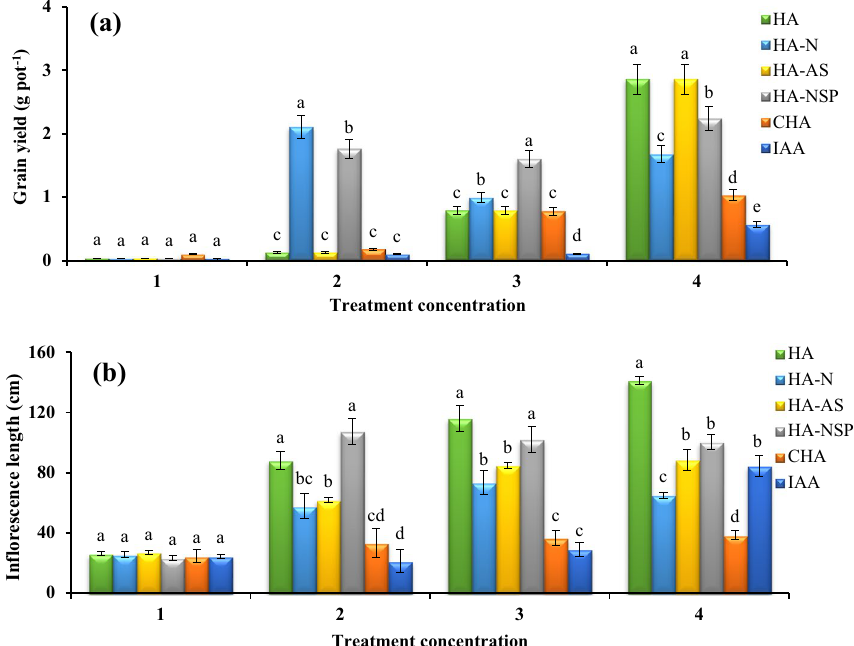
Figure 4. Comparison of average foliar application of experimental treatments on grain yield ( a ) and inflorescence length ( b ) at treatment concentrations (levels 1, 2, 3 and 4 for HA, HA-N, HA-AS, HA-NSP and CHA treatments of 0, 200, 400 and 600 mg L −1 and 0, 10 –6 , 10 –5 and 10 –4 molar IAA). Different letters in each figure show significant difference at p ≤ 0.05 by Duncan multiple range test. HA, HA extracted from vermicompost without enrichment; HA-N, HA extracted from vermicompost enriched with 1% nitrogen; HA-NSP, HA extracted from vermicompost enriched with 1% nitrogen, 1% sulfur, and 1% phosphorus; HA-AS, HA extracted from vermicompost enriched with Azotobacter chroococcum (21Az) + Pseudomonas fluorescens (Ps 59); CHA, Commercial humic acid; IAA, Indole-3-acetic acid (IAA).